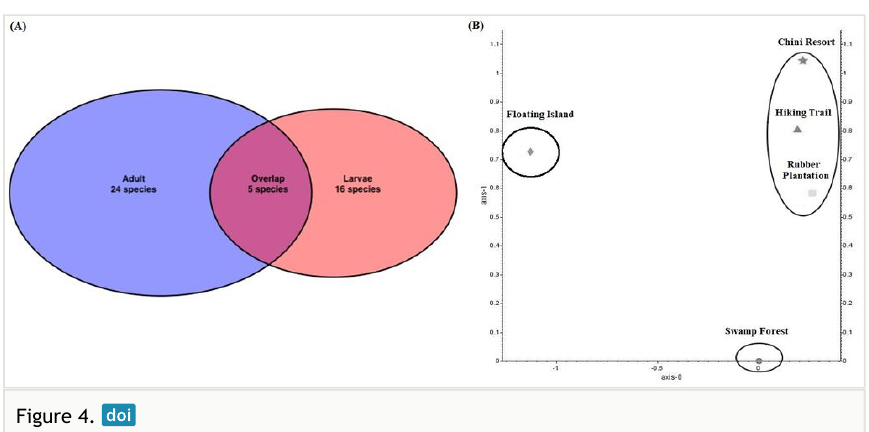
Mosquitoes captured between adult and larvae stages showed minimal overlap (A). Mosquito composition (both adults and larvae) at moderate to high-disturbed sites (disturbance score = 2.5 to 8) grouped, whereas the two low disturbance score sites differ from each other respectively